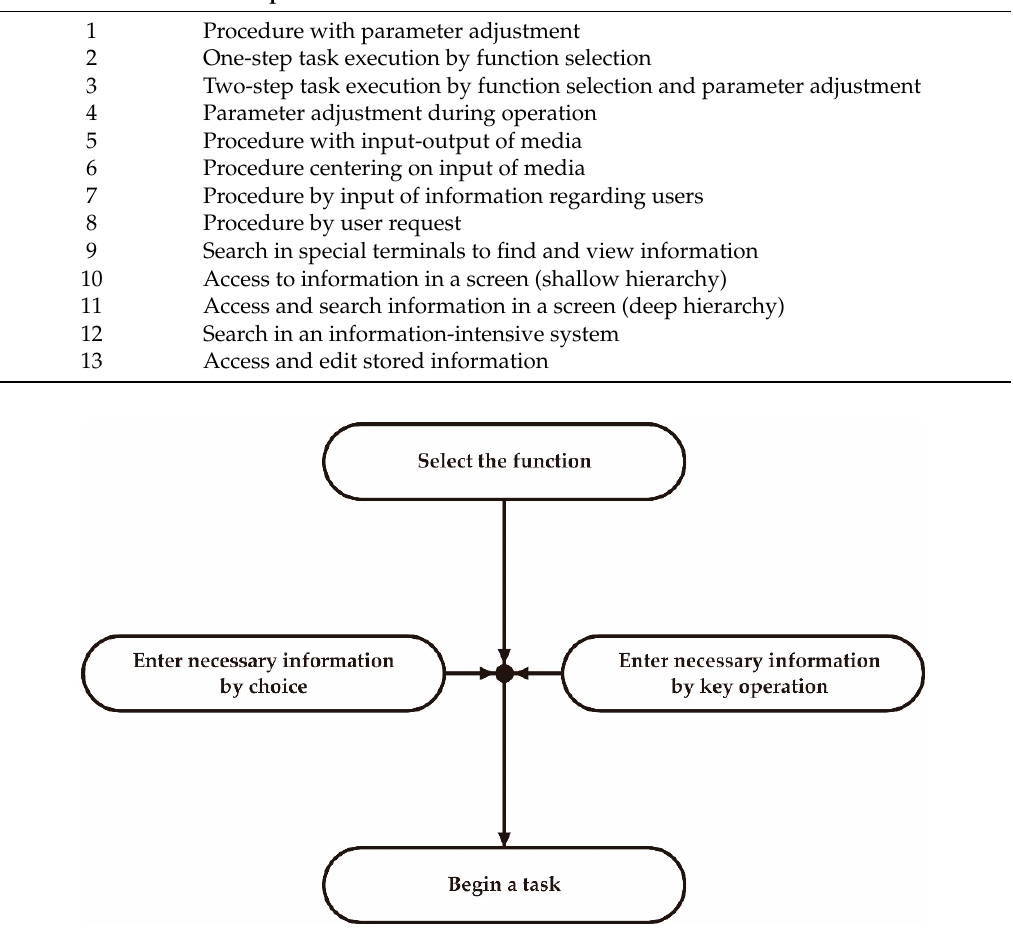
Figure 1. Example of task flow shown in the flow design pattern 1.